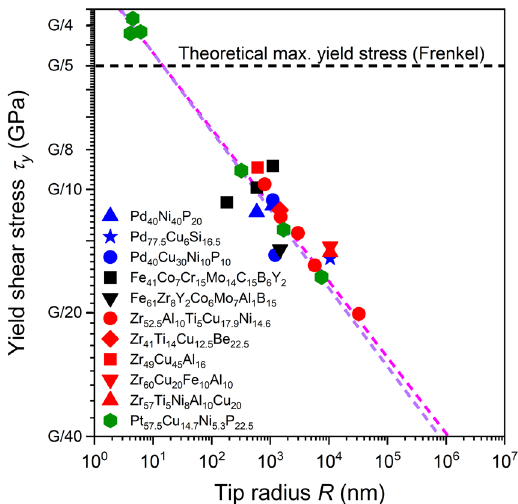
Fig. 4 Yield shear stress τ y as a function of indenter radius R . Plot of τ G , with G /40 re fl ecting the y in fractions of the shear modulus material ’ s bulk value. The green hexagons mark the results obtained on Pt 57.5 Cu 14.7 Ni 5.3 P 22.5 in this work while all other data points are taken from Fig. 2 in ref. 11 . Note that the fi t given in that reference, re fl ected by the dashed magenta line, coincides favorably with the dashed purple line we fi nd using Pt-BMG data R ≈ 320 nm, R ≈ 1.7 μ m and R ≈ 7.5 μ m tips, respectively) as well as for the G /4.1 – G /3.3 (i.e., τ y ≈ 8.9 – 11.2 GPa) values found with AFM indentation.